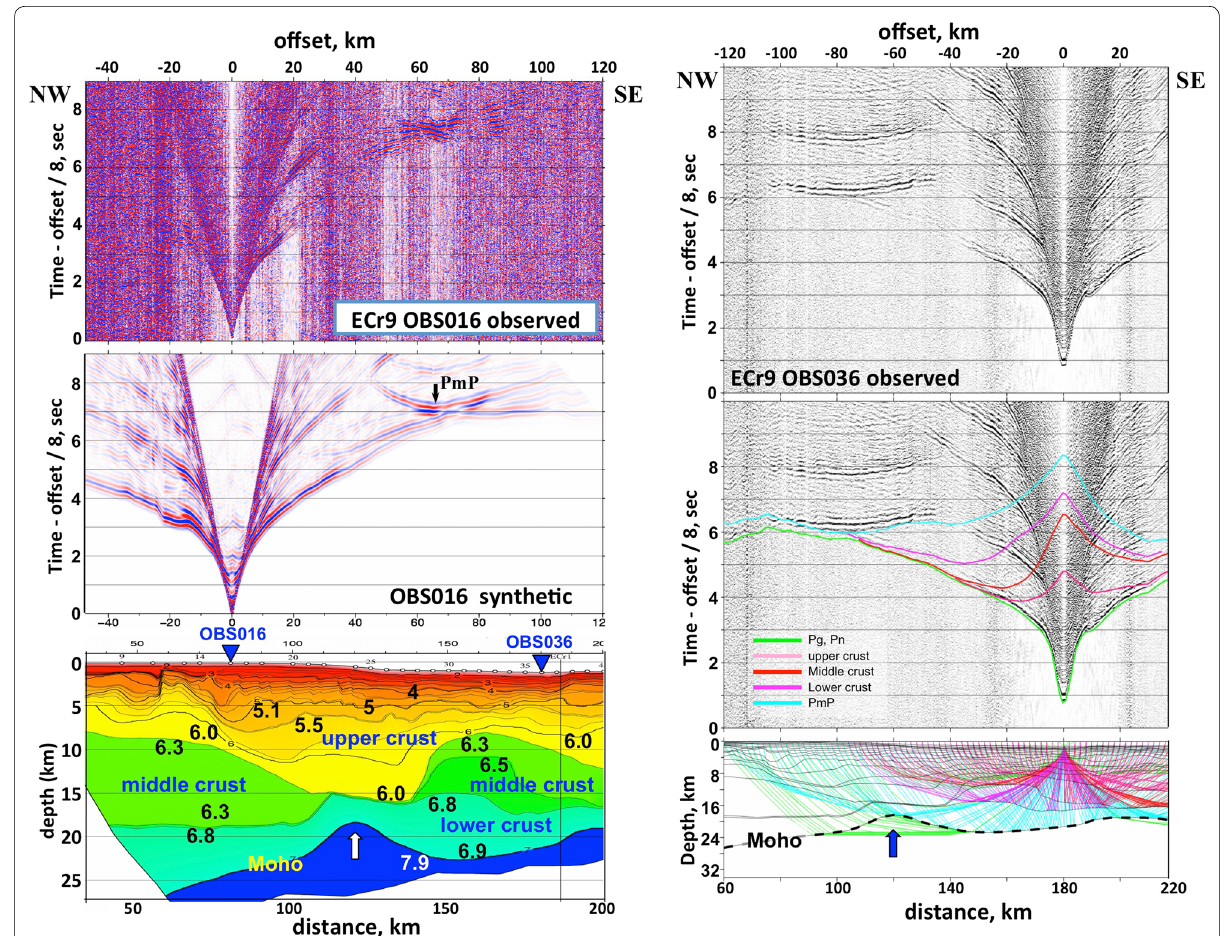
Fig. 8 Seismograms showing shallow Moho reflections below the slope for ECr9. Left: observed record section of OBS016 (top), synthetic seismogram (center), and V p model (bottom). Right: observed record section of OBS036 (top), calculated travel times on the record section (center), and ray diagram (bottom). These record sections are outputs of the vertical geophone. Predictive deconvolution, 4–20-Hz bandpass filter, and a gain factor proportional to distance were used to enhance signal-to-noise ratios. The reduction velocity is 8.0 km/s. The color of the calculated travel times corresponds to the ray path in the ray diagram. The ray paths are generated at equal distance. An arrow in the V p model indicates the position of the shallow